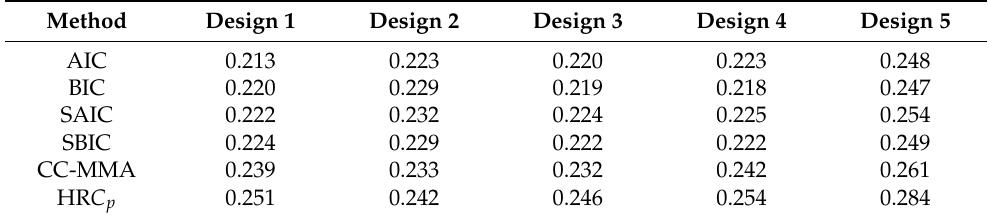
Table 2. Averaged computation time in seconds over 3 runs, when n = 100, R 2 = 0.1 and MR =